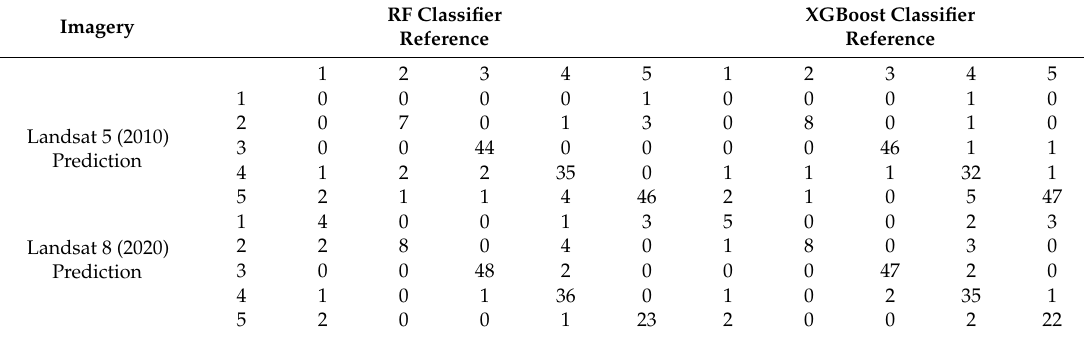
Table A2. Confusion matrix generated in Google Earth Engine (GEE) for the validation dataset. Here 1 is built-up class, 2 is water class, 3 is forest class, 4 is rocky/barren class, and 5 is cultivation class.